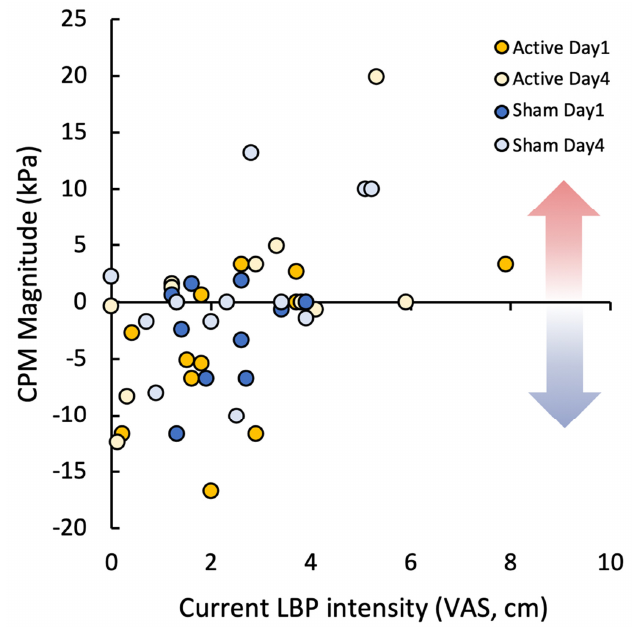
Figure 4. Scatter plot between CPM magnitude (cuff only) and current low back pain intensity scores on a visual analog scale for each session (Active Day1, Active Day4, Sham Day1, Sham Day4). Arrows indicate facilitation (red) and inhibition (blue) during CPM.